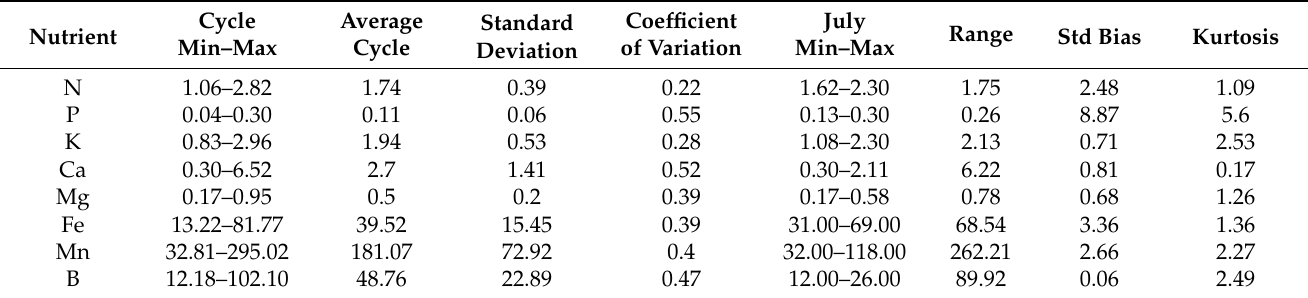
Table 2. Descriptive statistics of the leaf macro and micronutrient concentration determined in the vegetative cycle (April-November 2020) by conventional analytical methods. Macronutrients (N, P, K, Ca and Mg) are expressed in (%) of dry matter. Micronutrients (Fe, Zn and B) are expressed in (ppm).